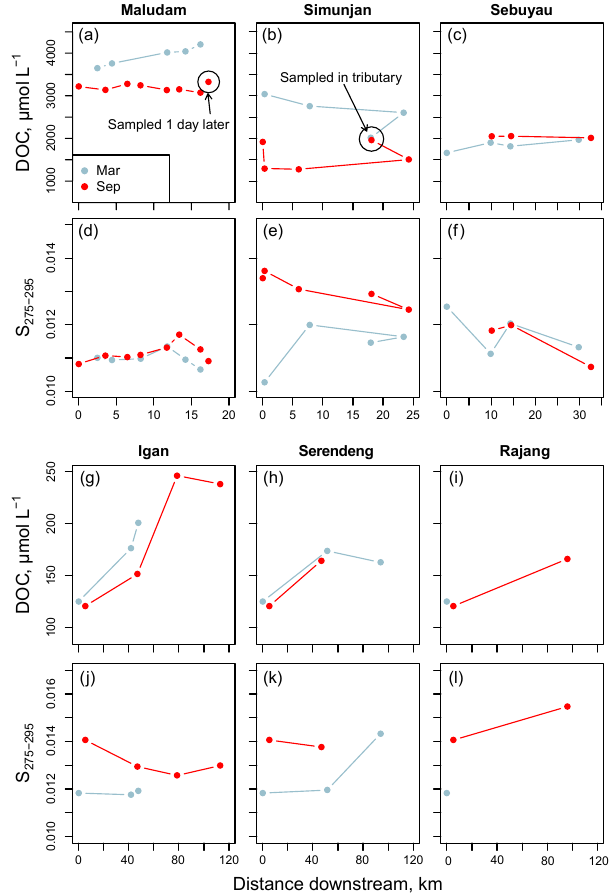
Figure 3. Changes in (a–c) and (g–i) dissolved organic carbon con- centration and (d–f) and (j–l) S 275–295 with distance downstream for all stations with salinity of 0. Data in (a–f) are for the Maludam, Simunjan, and Sebuyau rivers, while (g–l) show data for the three main Rajang distributaries (named in Fig. 1b): panels (h, k) show data for the Serendeng branch (includes the Lebaan and Paloh sec- tions), while panels (i, l) show data for the Rajang branch (includes the Payang